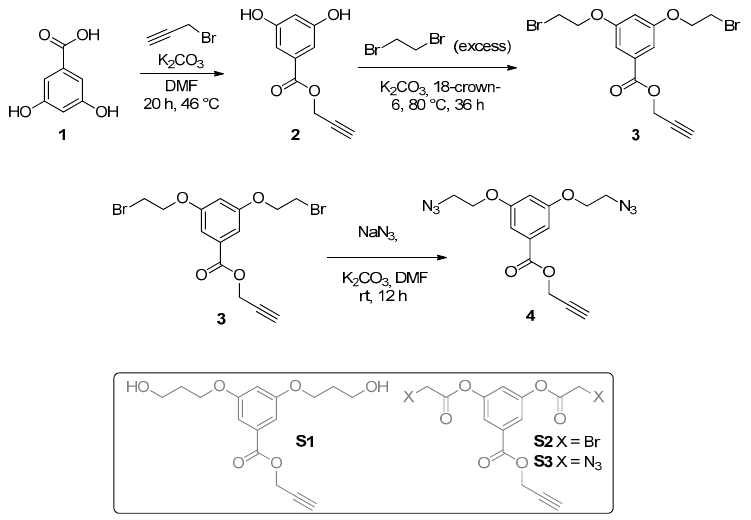
Scheme 1. Synthesis of AB 2 monomer 4 . Bo tt om: potential AB 2 monomers S1 and S3 , whose synthesis was not achieved (see Supporting Information Scheme